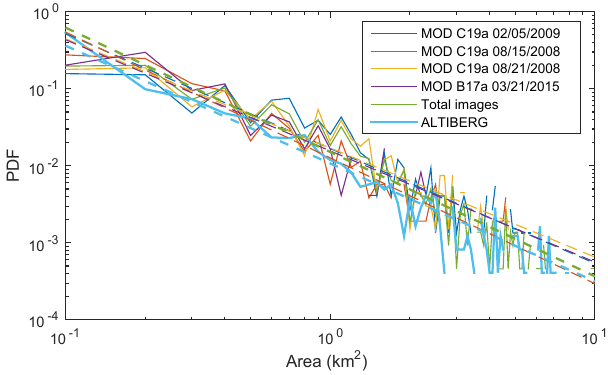
Figure 13. Probability density function of the fragment size de- tected on MODIS images (dark blue line C19a 5 February 2009, orange line C19a 15 August 2008, yellow line 21 August 2008, vi- olet line B17a 2 March 2015, green line all images), and detected by altimeter in the vicinity of C19a (turquoise line). The dashed straight lines represent the power law fit to the data. Dates are listed as